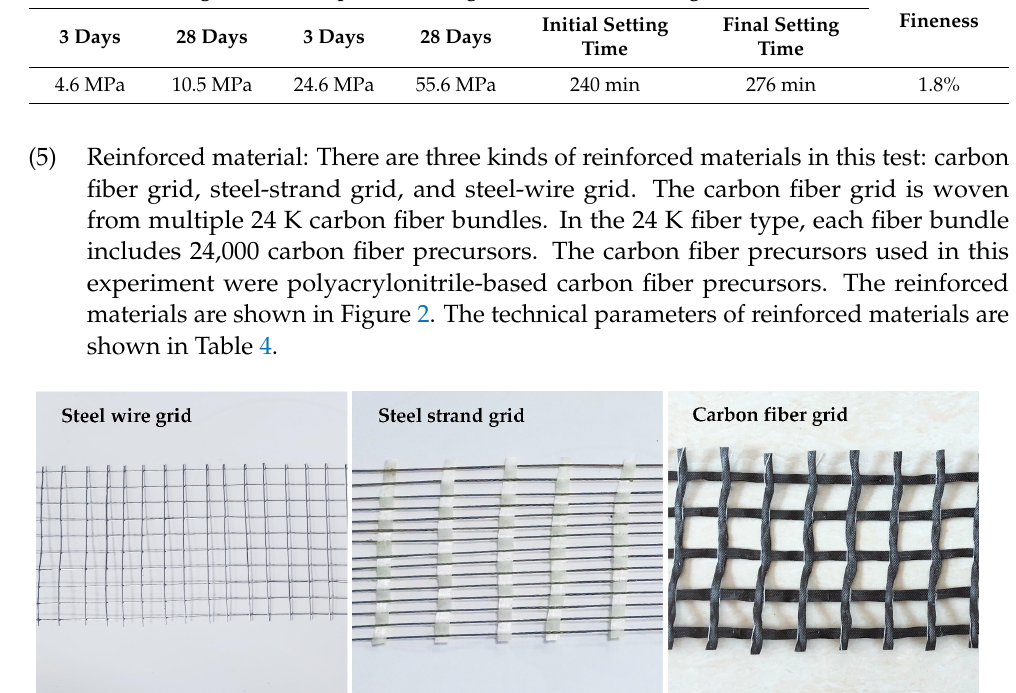
Table 2. Technical index of AC-10 fine-grained concrete.